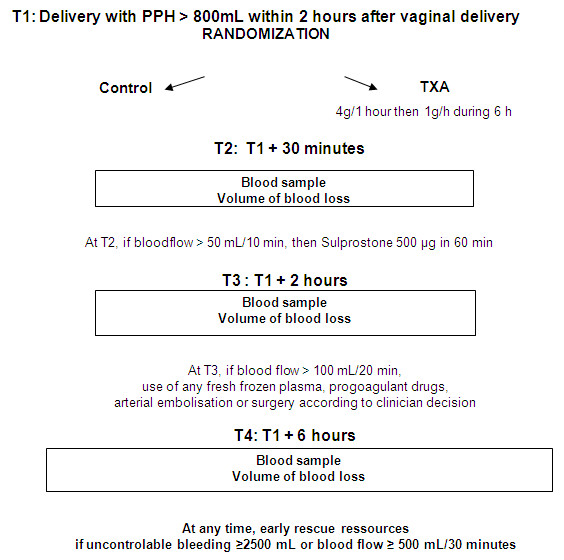
Diagram showing the study design. PPH, postpartum haemorrhage; TXA, tranexamic acid.